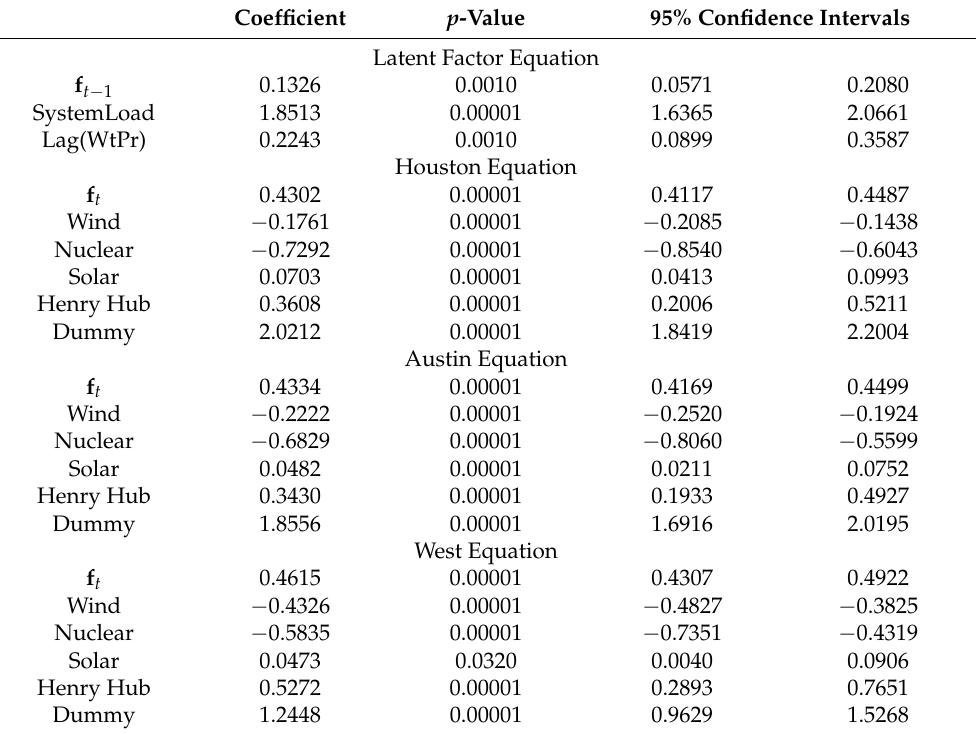
Table 6. ML coefficients for the 4:00 p.m.